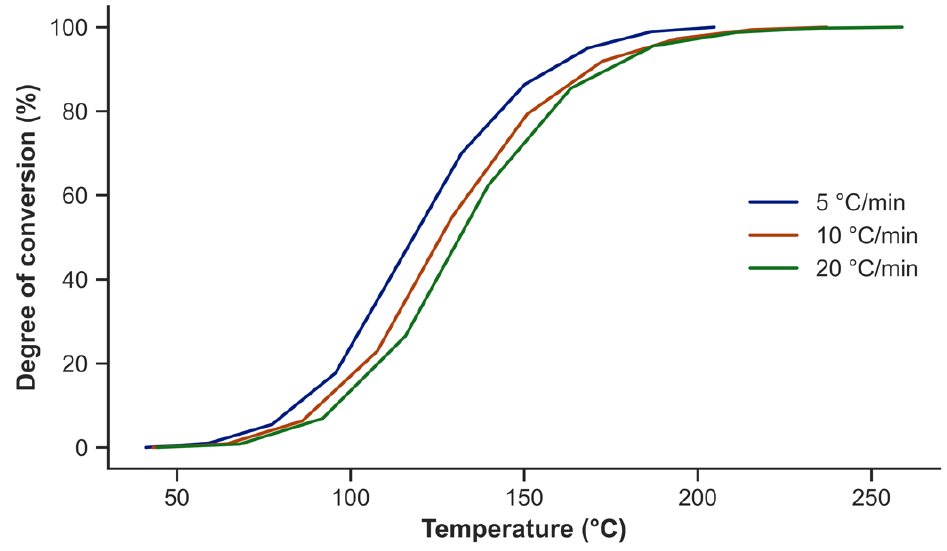
Figure 3. Degree of conversion as a function of temperature at different heating rates for the epoxy resin. Table 3. Curing peak temperatures and enthalpy of the epoxy resin.